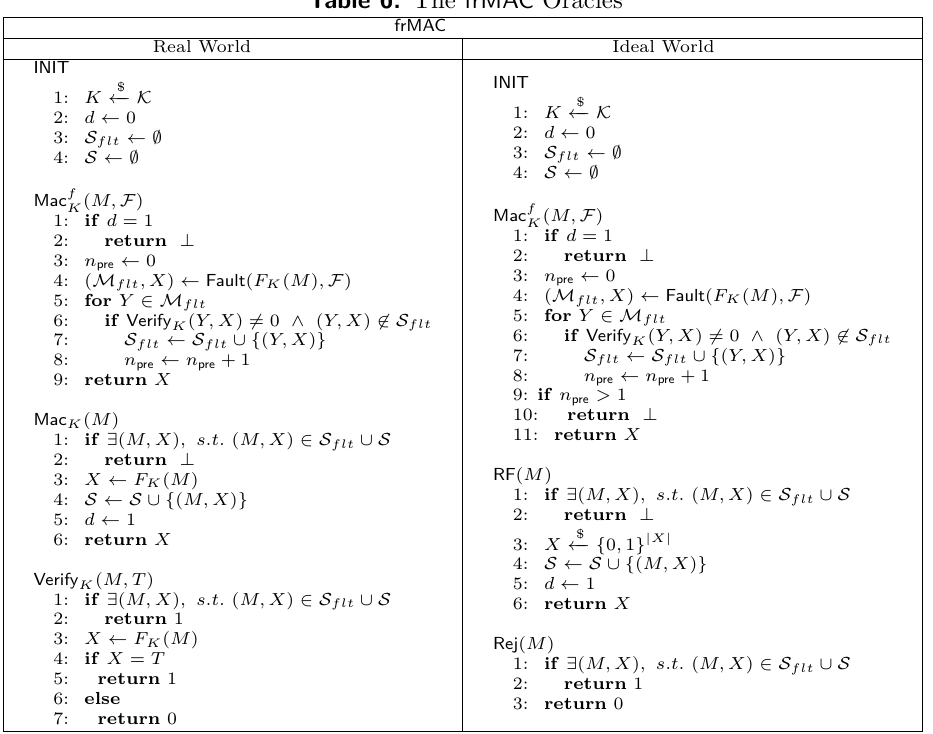
Figure 2: Fault-Resilient hash-then- PRF